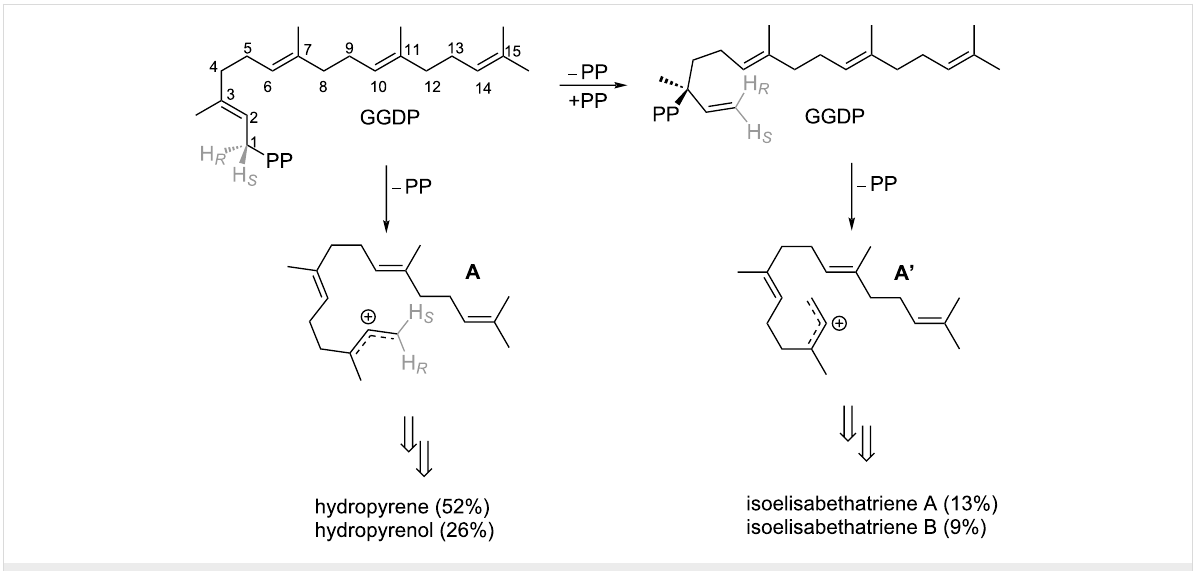
Figure 1: Summary of yields of HP and IE products in hydropyrene synthase.